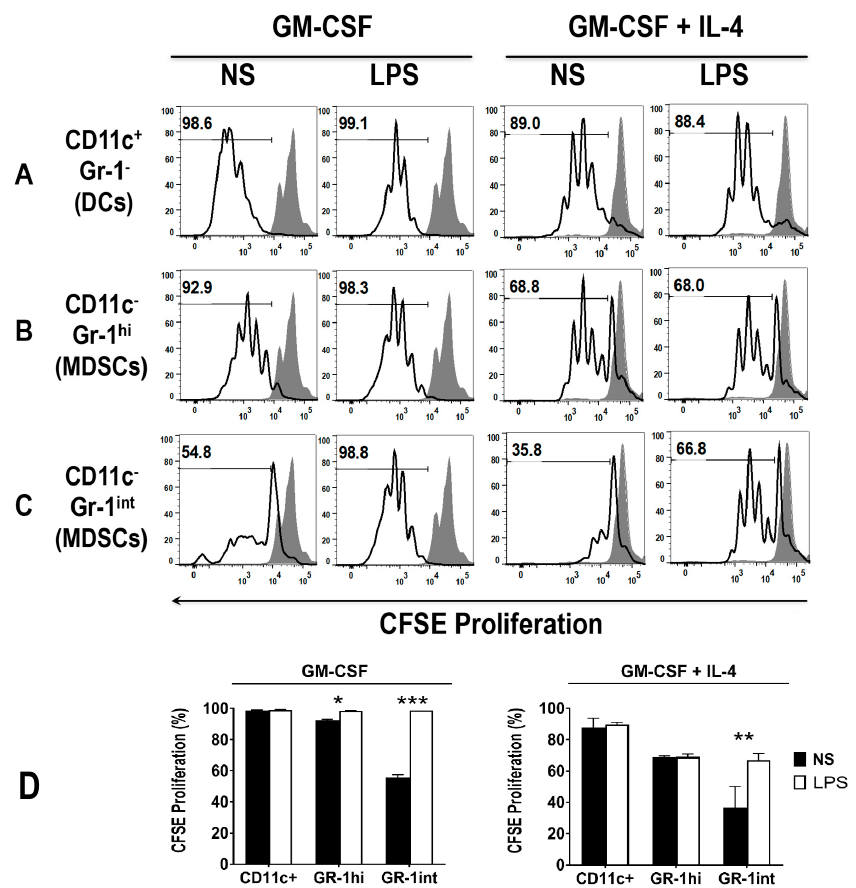
Figure 8. DCs and GR-1 hi MDSCs, but not GR-1 int MDSCs unless LPS stimulated, from both GM-CSF and GM-CSF + IL-4 cultures, co-stimulate T cell proliferation. Cells from day 4 GM-CSF derived C57BL/6 BM cultures were sorted with a FACS Aria cell sorter into ( A ) DCs, ( B ) Gr-1 hi MDSCs and ( C ) Gr-1 int MDSCs. These cells were either un-stimulated or pre-stimulated with LPS for 24 h before incubation with BALB/c T cells for 3 days at a ratio of 1:30 (DC: T cells) with the addition of anti-CD3 and anti-CD28 monoclonal antibodies (5 μ g/mL each). T cell proliferation was measured by CFSE proliferation. The shaded grey area represents the CFSE positive control. Numbers within the histograms depict percentage of cells proliferated. Histograms are representative of two to three mice. ( D ) represents mean percentage of CFSE proliferation +/ − SD of 2–3 mice. * p < 0.05, ** p < 0.01, *** p < 0.001.